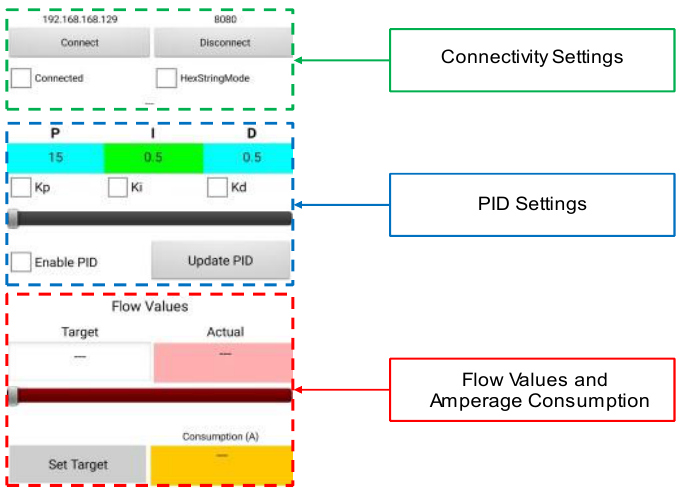
Figure 6. The Android smart phone/tablet Wi-Fi application interface as designed using the MIT App Inventor environment. App Inventor